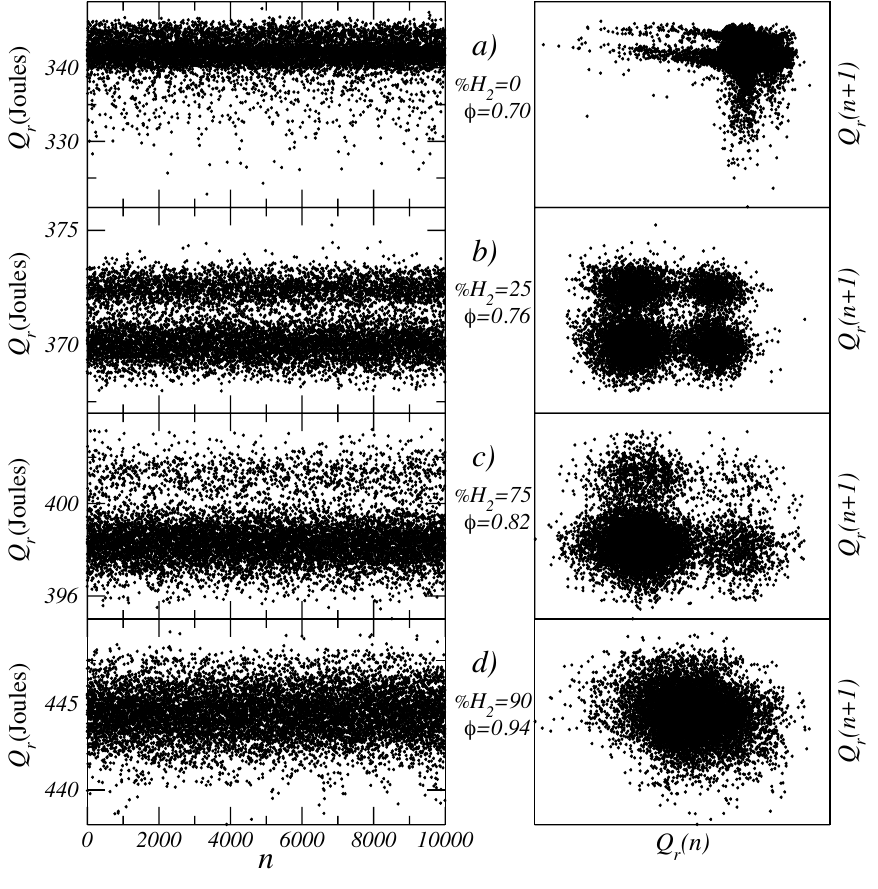
Figure 5. Representative cases of heat release sequences, x ( n ) (left side), and their corresponding first return maps (right side). ( a ) % H 2 = 0, φ = 0.70; ( b ) % H 2 = 25, φ = 0.76; ( c ) % H 2 = 75, φ = 0.82; ( d ) % H 2 = 90, φ =